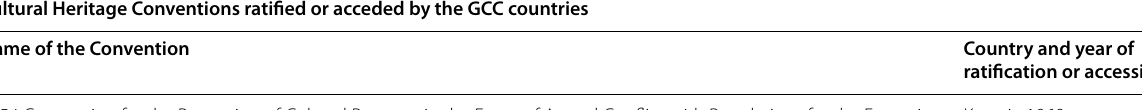
Table 1 Cultural Heritage Conventions ratified or acceded by the GCC countries